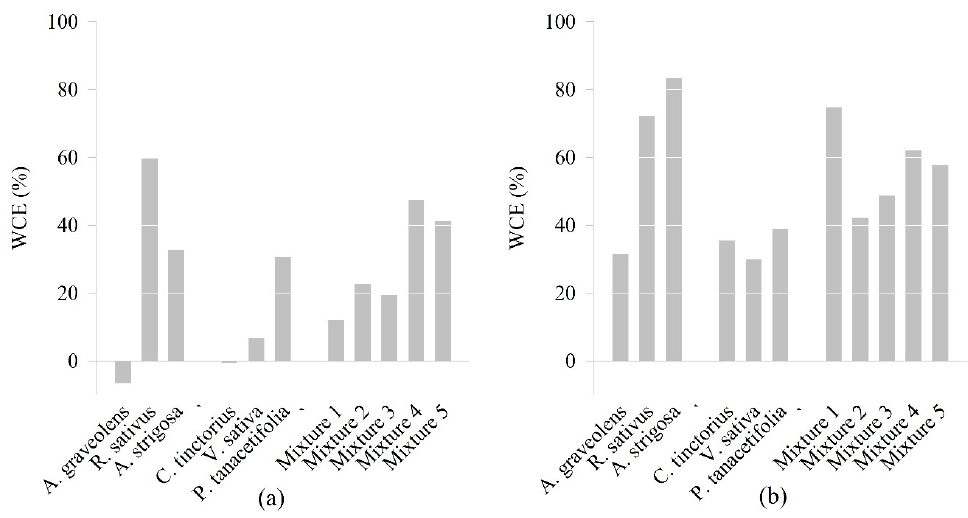
Figure 4. Weed control efficacy (WCE) of the six single sown and five cover crop mixtures 12 weeks after sowing in 2016 ( a ) and 2017 ( b ). Means with no letters do not differ significantly according to Tukey-HSD test ( p ≤ 0.05).